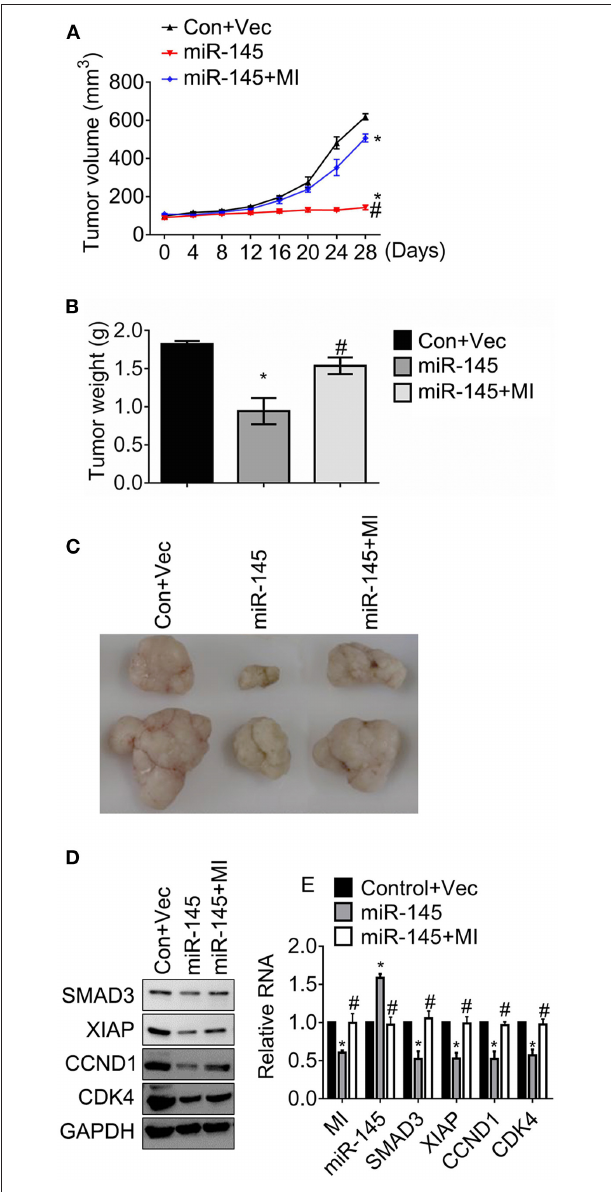
FIGURE 6 | MIR570MG restores resistance against regorafenib by sponging miR-145 in HCT116R xenografts. Mice carrying ∼ 100mm 3 tumors were divided into three groups randomly (six per group) and tumor volumes were measured. (A) Tumor growth curves of HCT116R mouse models. (B) Tumor weights of HCT116R mouse models. (C) Representative images of tumors in each group. (D) The indicated protein expression was accessed by immunoblot. (E) The indicated lncRNA, miRNA and mRNA expression were analyzed by qRT-PCR. Data obtained from three independent experiments. * P < 0.05, vs. control. # P < 0.05, vs. miR-145. Con, control; Vec, vector; MI,